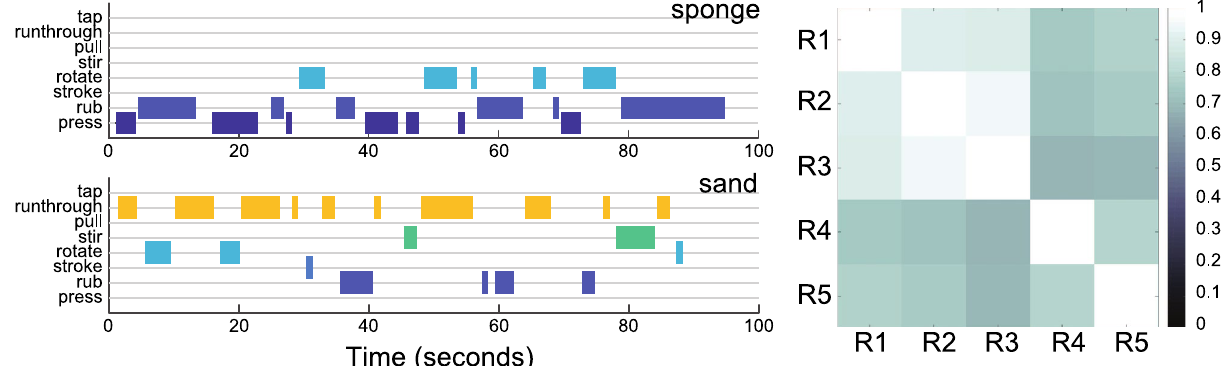
Figure 4. Left: Timeline output from BORIS shows two example observations for sponge (top) and sand videos (bottom, of one rater and 1 participant). For sponge, the observation starts with pressing and then rubbing, where these two EPs are intermittently coded at the beginning (first 30 s) of the video, then rotating is also included. Similarly, for sand, the rater codes running through and rotation; then stroking, rubbing, and stirring. For EP frequency analysis, the durations of a given EP are added and divided by the total duration of all EPs. Right: Shown are the correlation coefficients between raters for 50 video clips, where each square represents the average of correlation coefficients of pairwise correlations of 50 × 8 arrays of EP frequencies per rater. Lighter colors indicate higher correlation